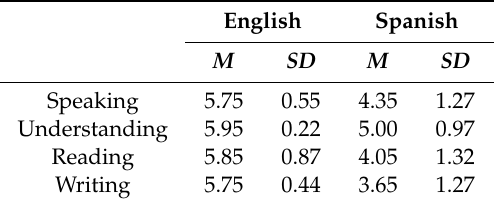
Table 2. Self-reported proficiency (scale